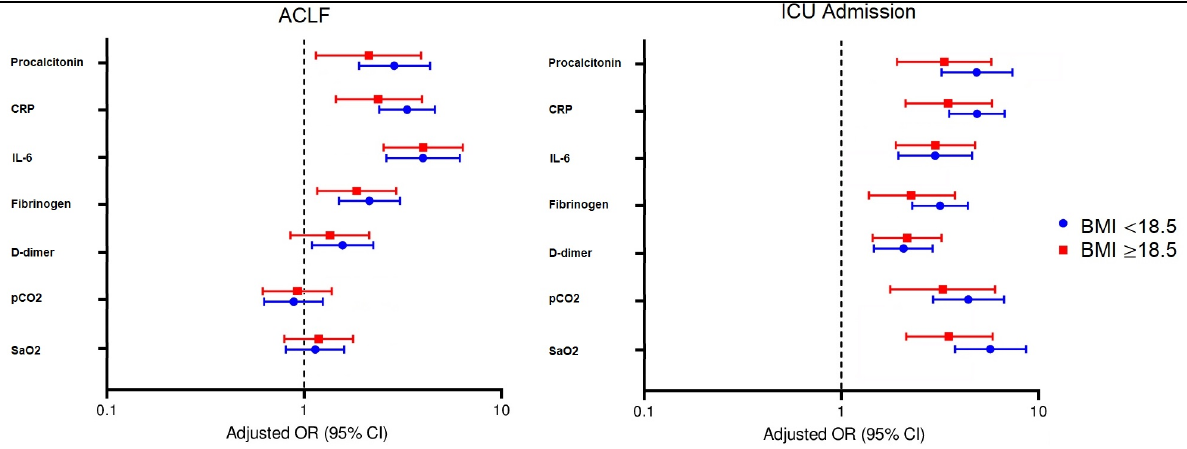
Figure 1. The association of laboratory parameters with ACLF and ICU admission in underweight and normal weighted patients with cirrhosis from the two study groups.